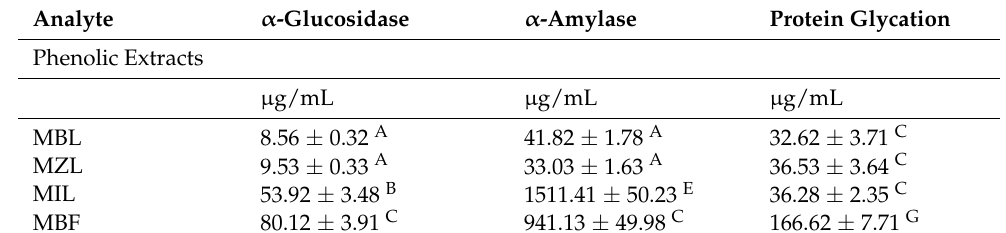
Table 2. Inhibitory effects (IC 50 ) of Cotoneaster leaf and fruit extracts and individual phenolics on α -glucosidase, α -amylase, and protein glycation. Analyte α -Glucosidase α -Amylase Protein